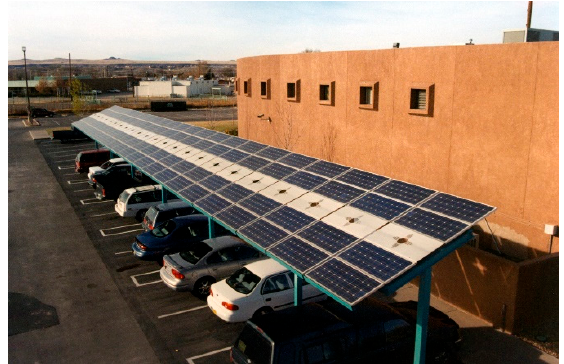
Figure 9. Example of a PV charging carport [30].